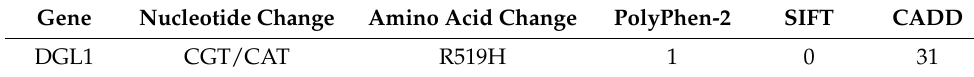
Table 1. In silico predicted pathogenicity of the DLG1